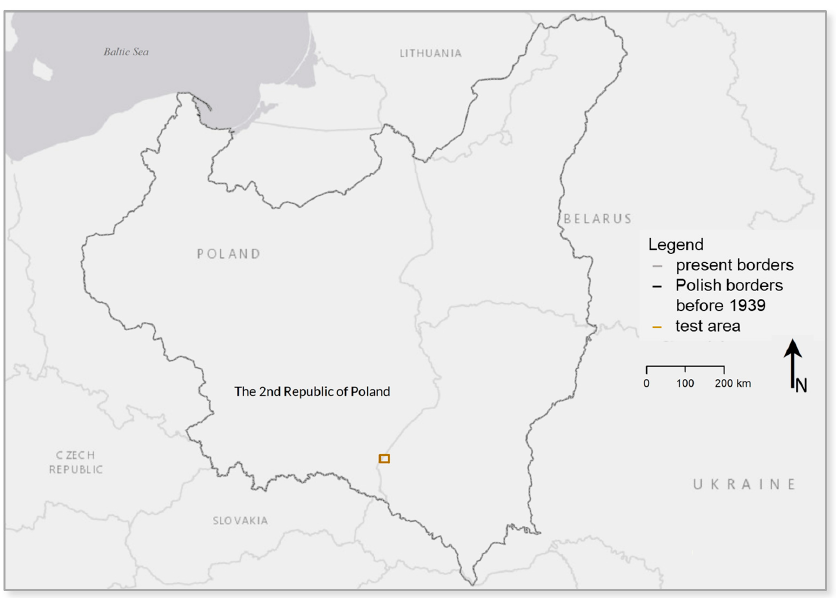
Figure 4. Borders in different time periods: light grey—present borders, dark grey—Polish border before 1939 (Second Republic, in Polish: the Second Republic—II Rzeczpospolita), small brown rectangle—test area (source: own work).